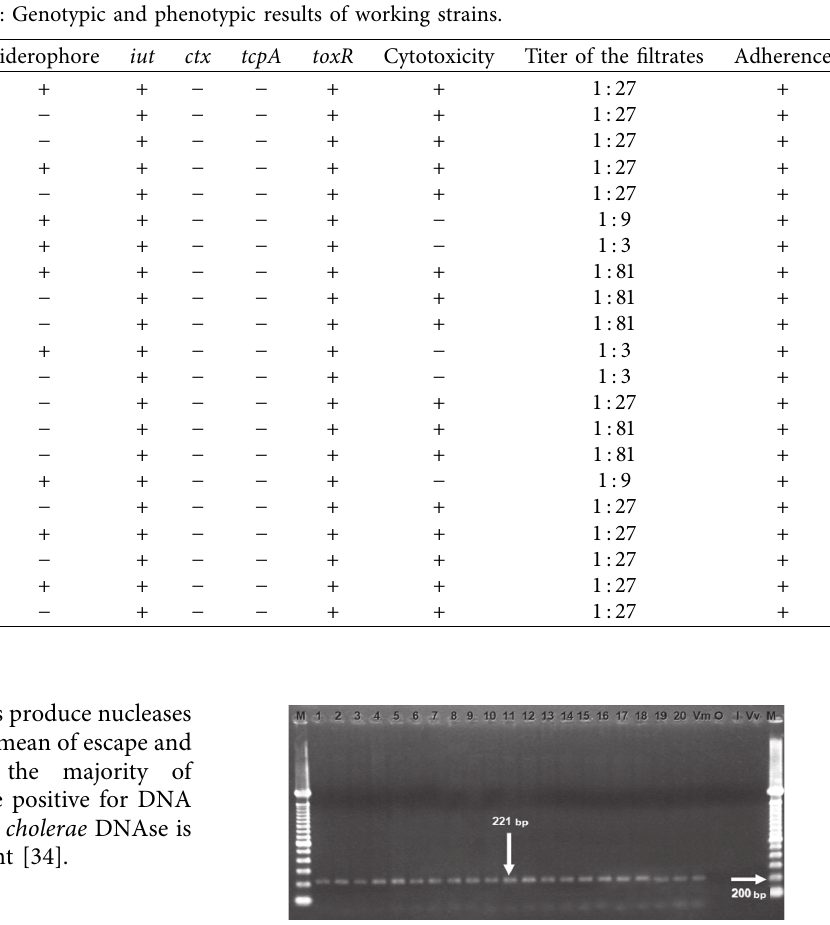
Figure 2: Electrophoresis gel of toxR gene amplification product. Lanes (M): 100bp molecular weight marker; lane 1: V. mimicus ATCC 33653; lanes 2–20: isolated strains of V. mimicus ; lane (O): V. cholerae O1 Ogawa; lane (I): V. cholerae O1 Inaba; lane (Vv): V. vulnificus ATCC